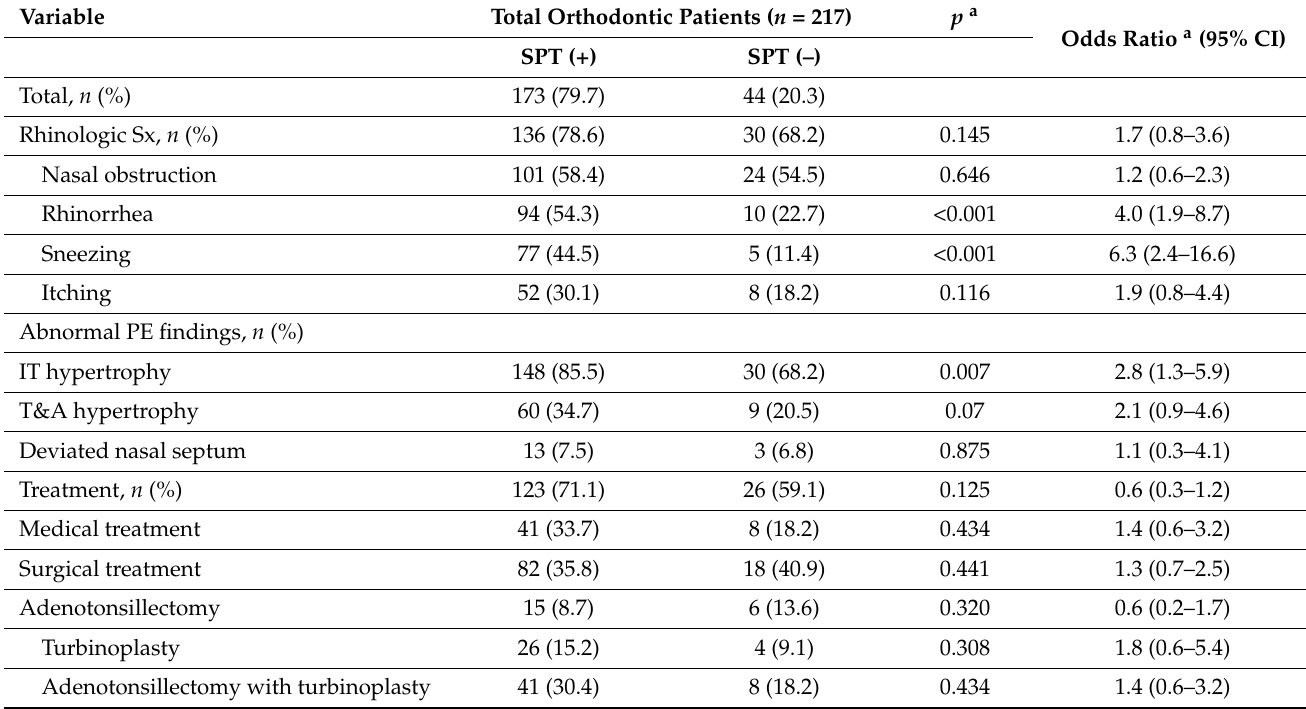
Table 3. Comparison of demographic and clinical characteristics between skin prick test (+) and skin prick test ( − )